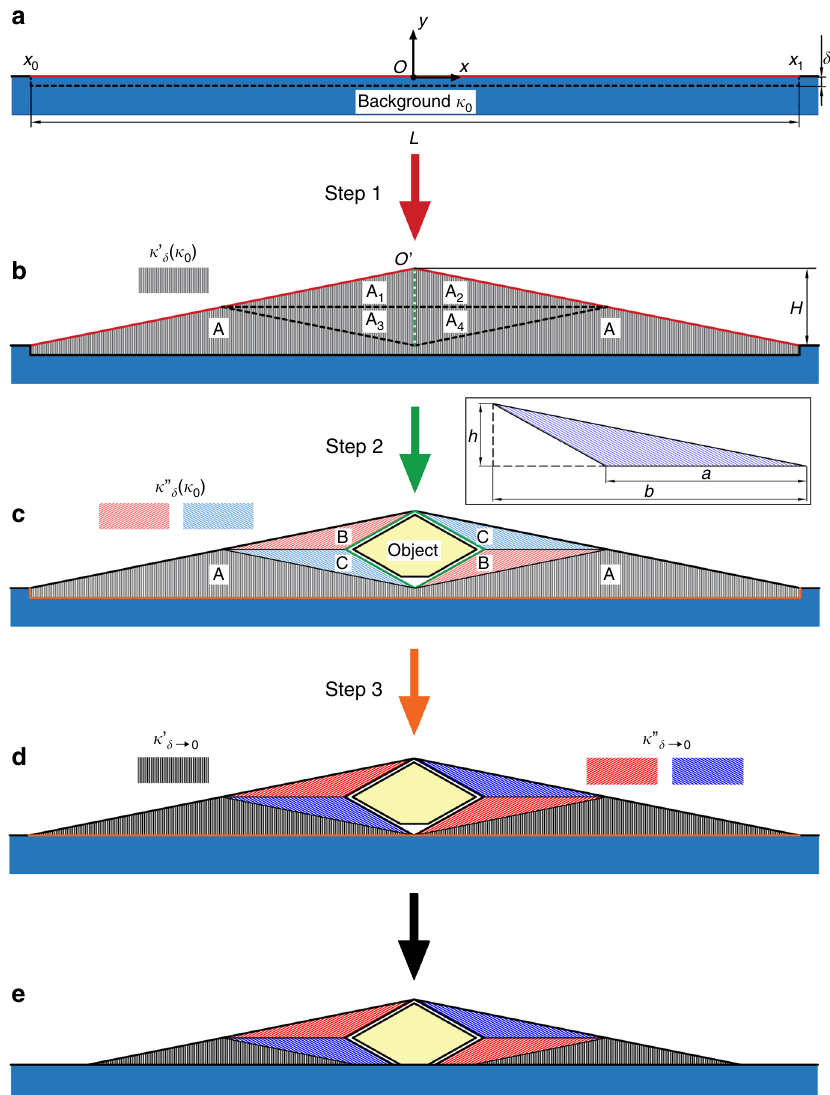
Fig. 2 Three steps to design the camou fl aging device. Starting from a pure background (blue coloured) with conductivity κ 0 , a Cartesian system ( x , y ) is constructed with its origin O on the background surface. Each step is represented with an arrow of a particular colour. The lines with the same colour are the deformed boundaries of that step. a , b Step 1: space creation. Stretch a small region of height δ (from x 0 to x 1 ) at the surface of the background to form a wedge (shaded with grey lines). The resulting conductivity κ ′ is dependent on κ 0 . b , c Step 2: perform the transformation of a unidirectional thermal cloak (shaded with pink and cerulean lines) on the created space to place the object (yellow coloured). The transformation keeps Region A unchanged, and compresses Region A 1 and A 4 to Region B, Region A 2 and A 3 to Region C. The resulting conductivity κ ′′ is dependent on κ ′ , thus also dependent on κ 0 . c ,